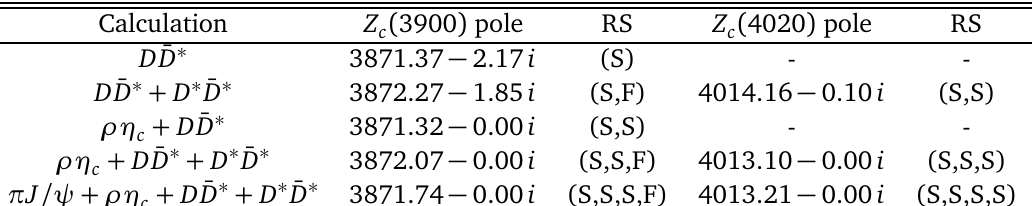
Table 1: The S -matrix pole positions, in MeV / c 2 , for different coupled-channels calculations. The included channels for each case are shown in the first column. Poles are given in the second and fourth columns by the value of the complex energy in a specific Riemann sheet (RS). The RS columns indicate whether the pole has been found in the first (F) or second (S) Riemann sheet of a given channel. Each channel in increasing energy.